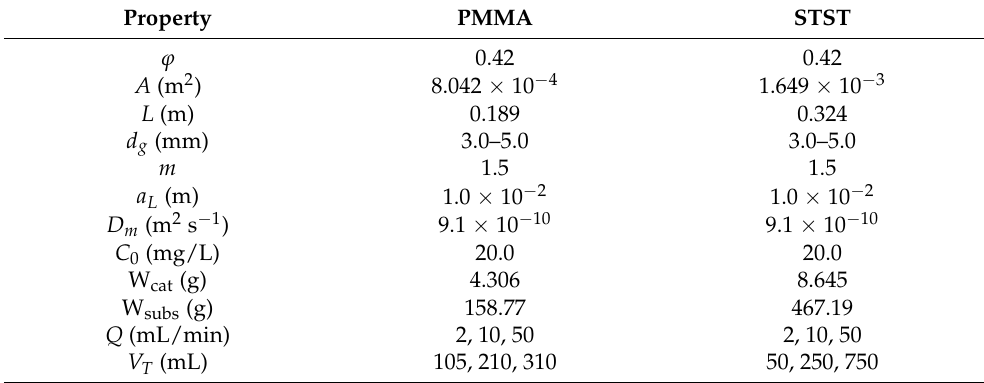
Table 1. Geometrical properties of fixed-bed photoreactors and experimental conditions.